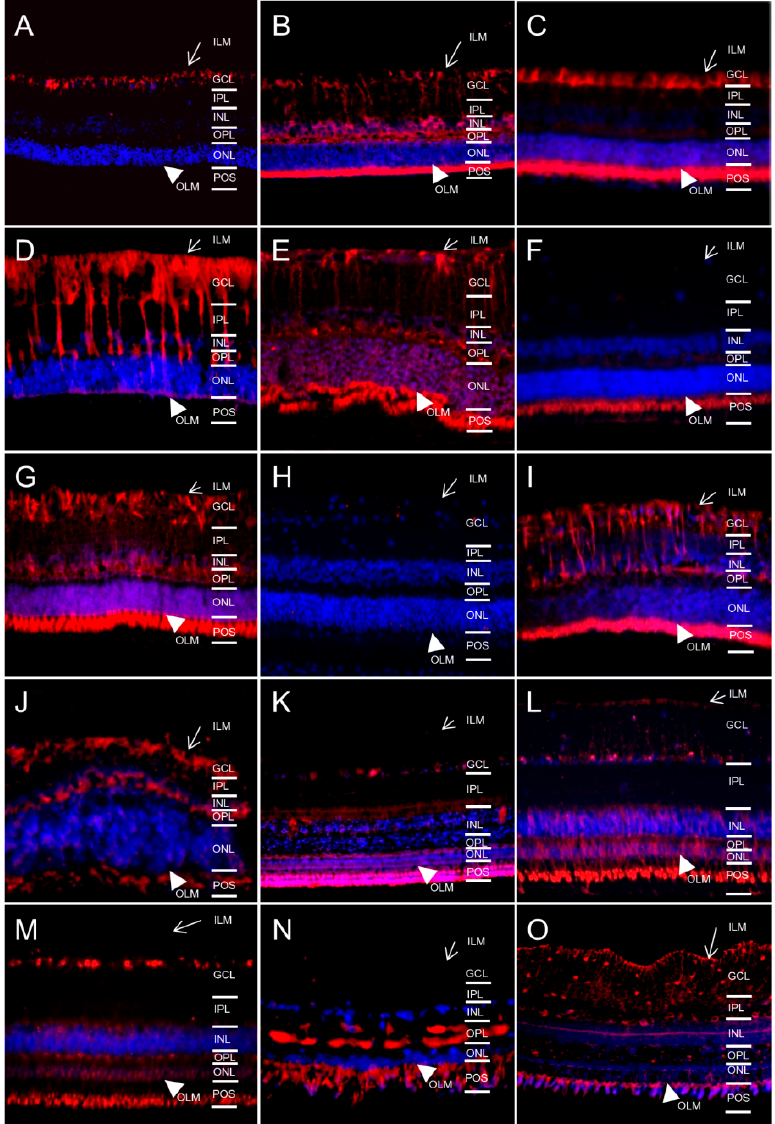
Figure 3. Expression patterns of AQP11 (red) in retinas of different species (magnification ×40). ILM, inner limiting membrane (arrow); GCL, ganglion cell layer; IPL, inner plexiform layer; INL, inner nuclear layer; OPL, outer plexiform layer; ONL, outer nuclear layer; OLM, outer limiting membrane (arrowhead); POS, photoreceptor outer segments. ( A ) mouse; ( B ) rat; ( C ) guinea pig; ( D ) horse; ( E ) cow; ( F ) sheep; ( G ) deer; ( H ) pig; ( I ) cat; ( J ) dog; ( K ) pigeon; ( L ) chicken; ( M ) pheasant; ( N ) sturgeon; ( O ) char. Cell nuclei: blue (DAPI).